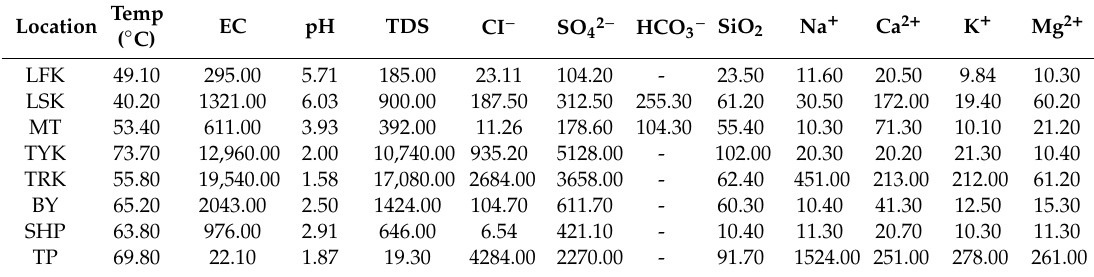
Table 2. Chemical composition of springs from the Tatun geothermal field in Taiwan. (T in ◦ C, EC in µ s / cm, concentrations in mg / L, -: not